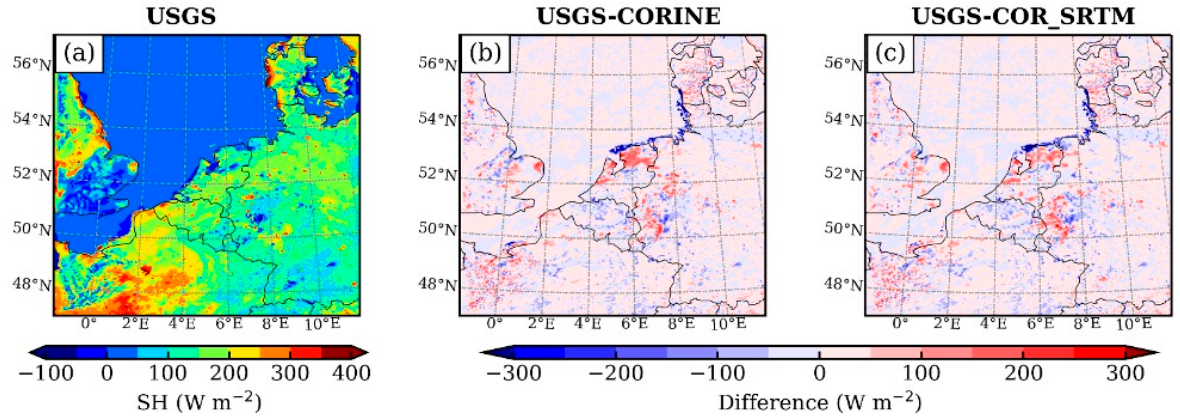
Figure 6. Sensible heat fluxes according to ( a ) USGS, and differences in LH between ( b ) USGS and Corine and ( c ) USGS and Corine + SRTM at 12 UTC on 18 August 2011. Corine and ( c ) USGS and Corine + SRTM at 12 UTC on 18 August